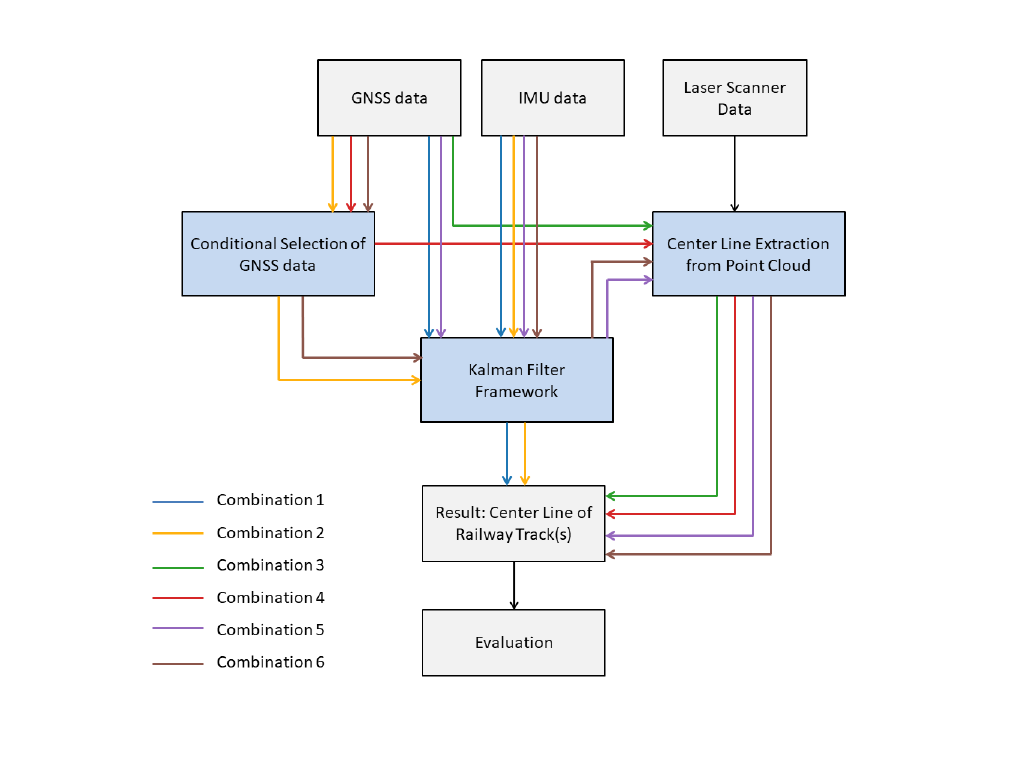
Figure 1. Workflow for the investigated combinations of methods. The figure illustrates how the global navigation satellite system (GNSS), inertial measurement unit (IMU), and laser data are processed using combinations (indicated by arrows of different colors) of three different methods (blue boxes) to yield center lines of railway